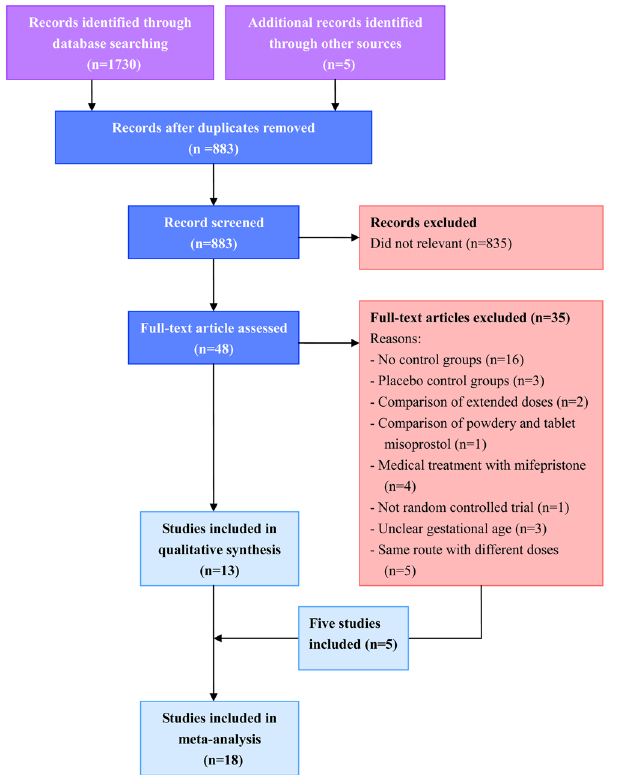
Figure 1. Article retrieval and